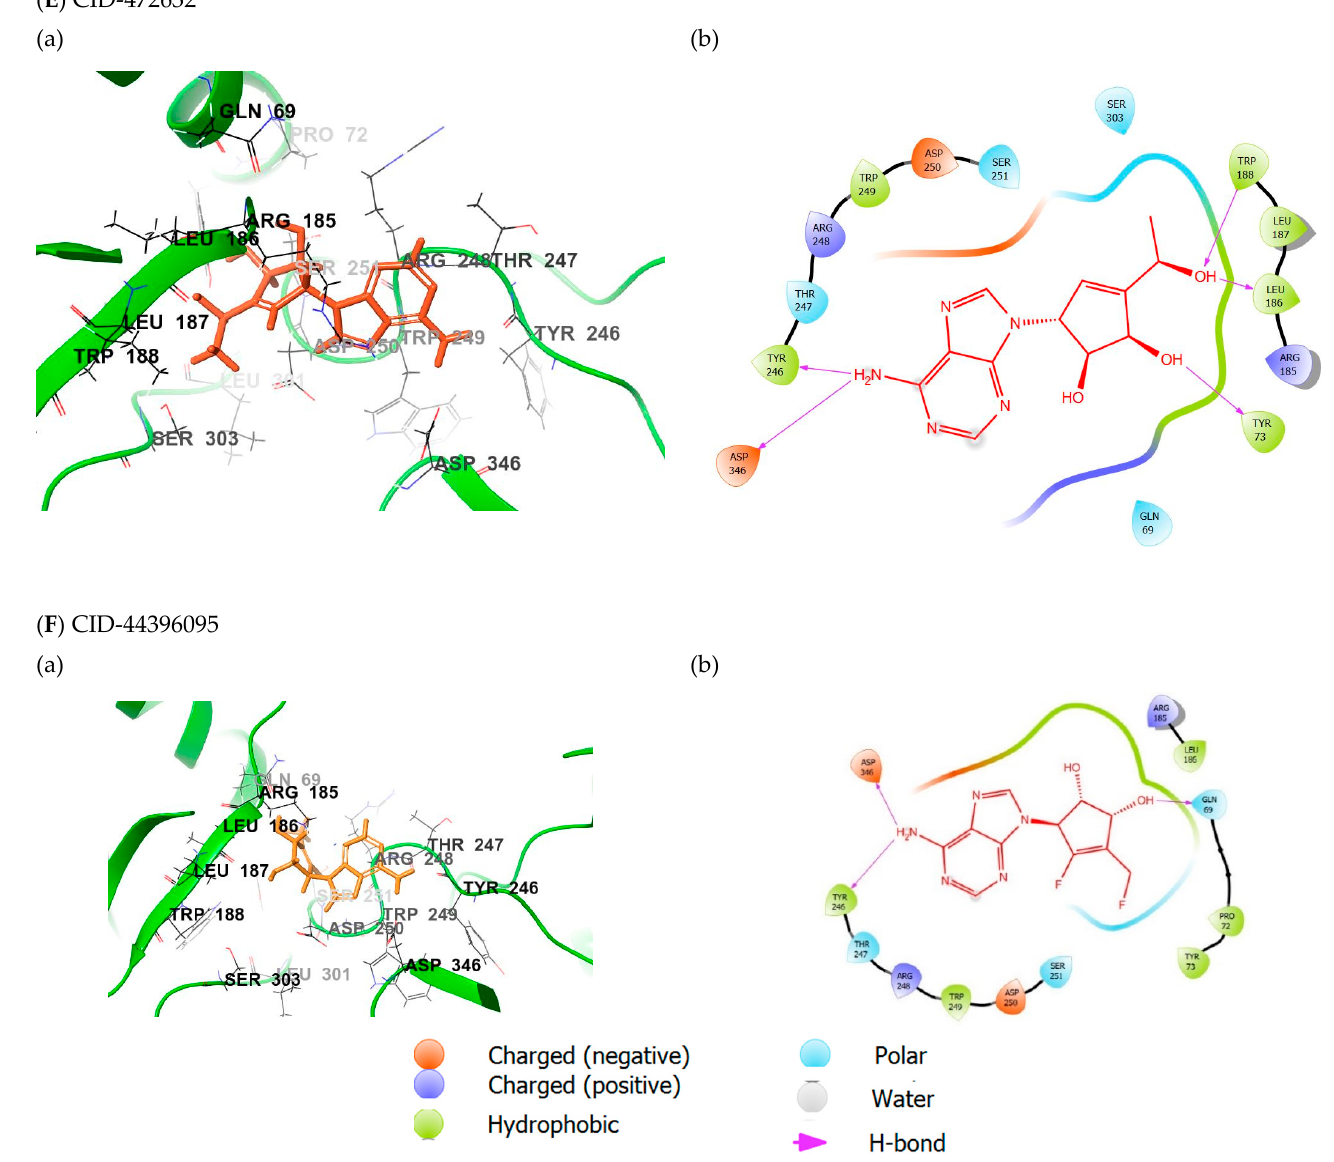
Figure 4. ( a ) The binding mode of the potent compounds as found by XP docking in the active site of MNV RdRp (cartoon) ( A ) CMX521 ( B ) CID-122178506 ( C ) CID-57930781 ( D ) CID-16723073 ( E ) CID-472632 and ( F ) CID-44396095. ( b ) The